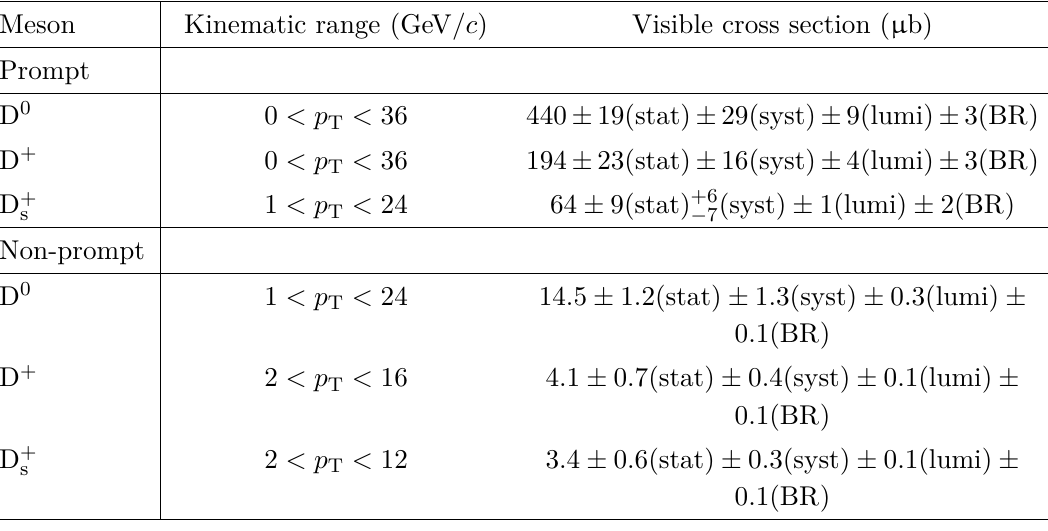
Table 3 . p T -integrated production cross sections in the measured p T range for prompt and non-